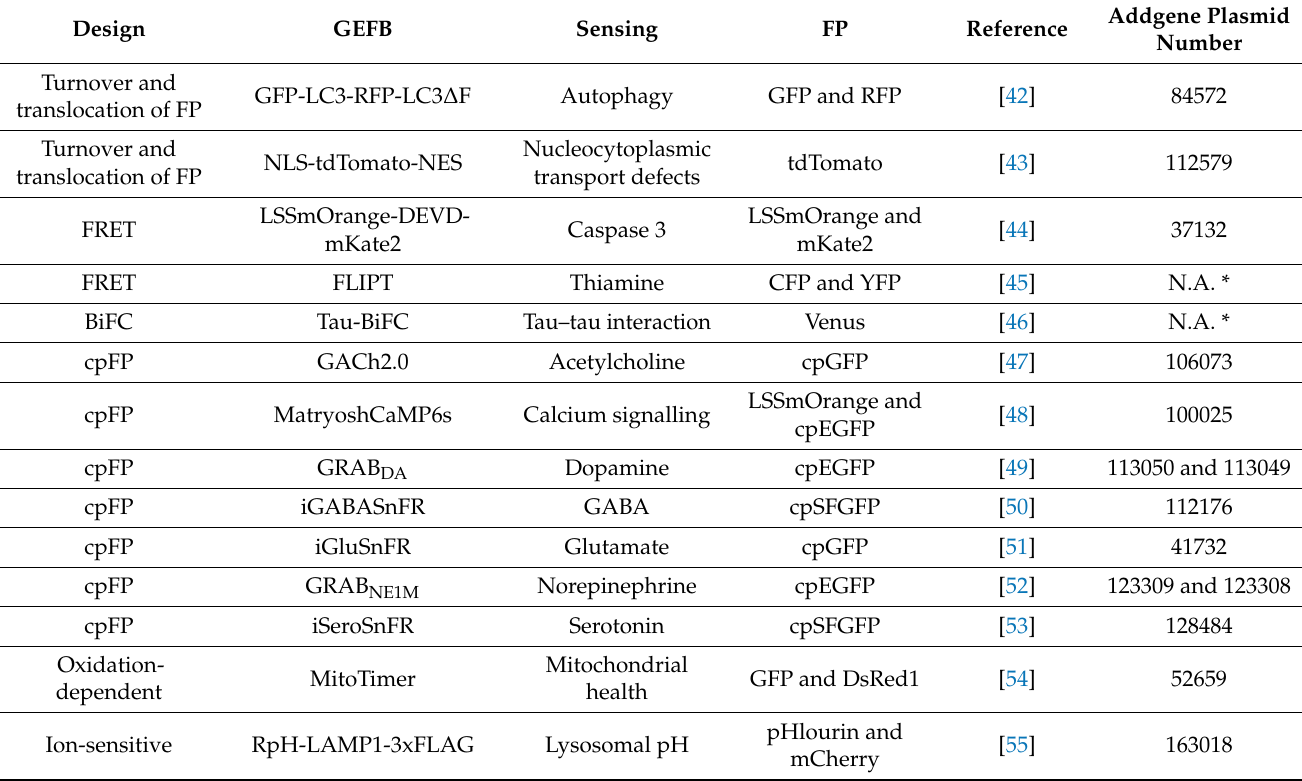
Table 2. Selected GEFBs relevant to neurodegenerative